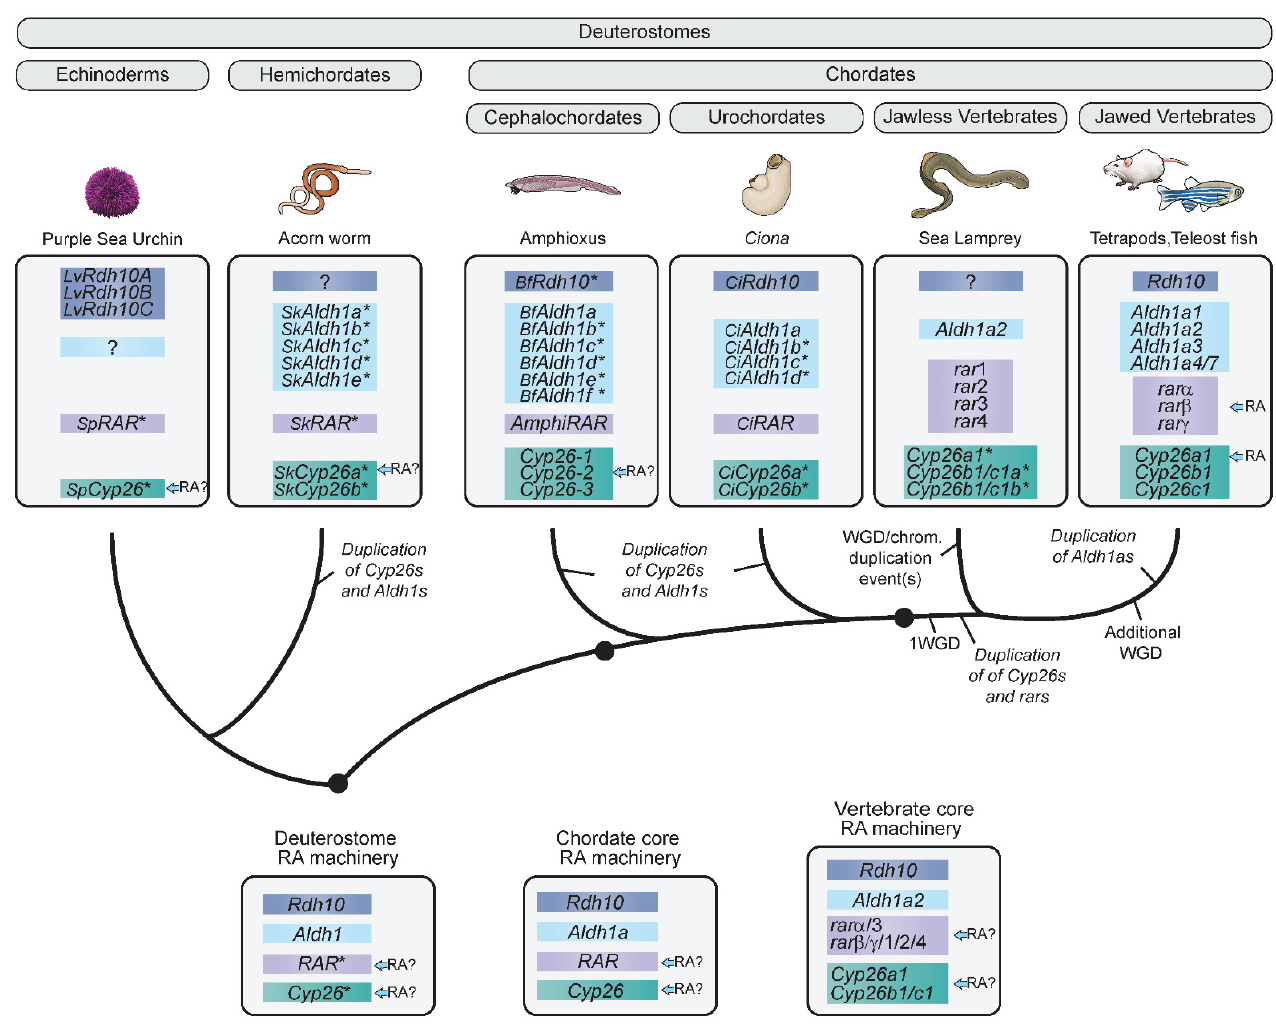
Figure 5. Origins and evolution of the RA machinery in deuterostomes. Schematic phylogenetic tree of the evolution of the RA machinery in deuterostomes in relation to major events of genome rearrangement. This diagram combines components of the RA machinery that have been functionally characterized with some previously published in silico work. Gene families of the major components of the RA machinery that this review focuses on—the Rdh10, Aldh1, RAR and Cyp26 families—are color-coded in accordance with Figure 2. Genes found in silico that have not been functionally validated are indicated with an asterisk (*). Question marks in colored boxes indicate that no gene has been described to this date. The RA-dependent regulation (blue arrow), e.g., Cyp26a1 , and presumptive RA-dependent regulation (blue arrow-question mark) of certain components of the RA machinery are indicated. Important events in the evolution and elaboration of the RA machinery, i.e., independent lineage-specific duplications of certain components, are indicated in the tree. Inferred models for the RA machinery with respect to different evolutionary time points are summarized at the bottom. Jawed vertebrate gene names are based on mouse and zebrafish models. Lv , L. variegatus ; Sp , S. purpuratus ; Sk , S. kowalevskii ; Ci , C. intestinalis ; Bf , B. floridae ; Amphi , Amphioxus. Cartoons of different model organisms are adapted from